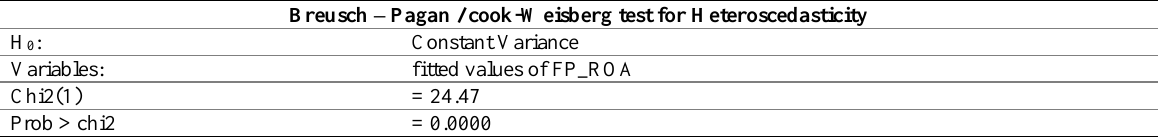
Table 2: Results of the Heteroscedasticity test